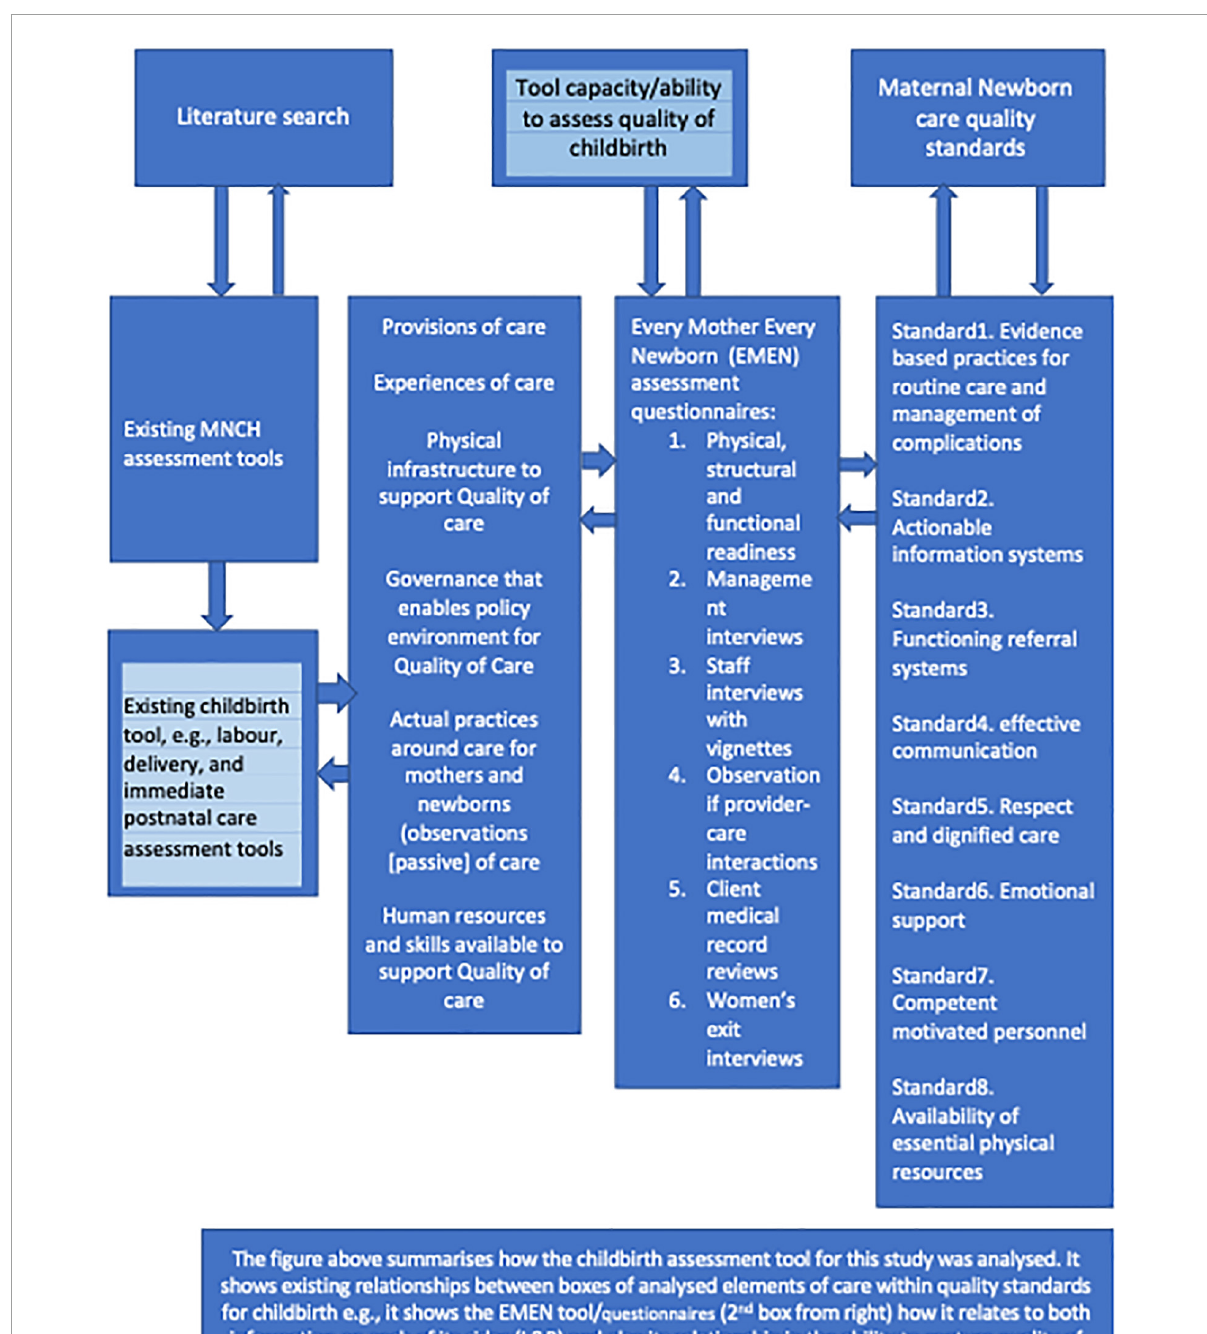
FIGURE2 Conceptual model for analysis of childbirth healthcare assessment tools: A comprehensive measure of care elements (inputs, process and output, and outcomes).